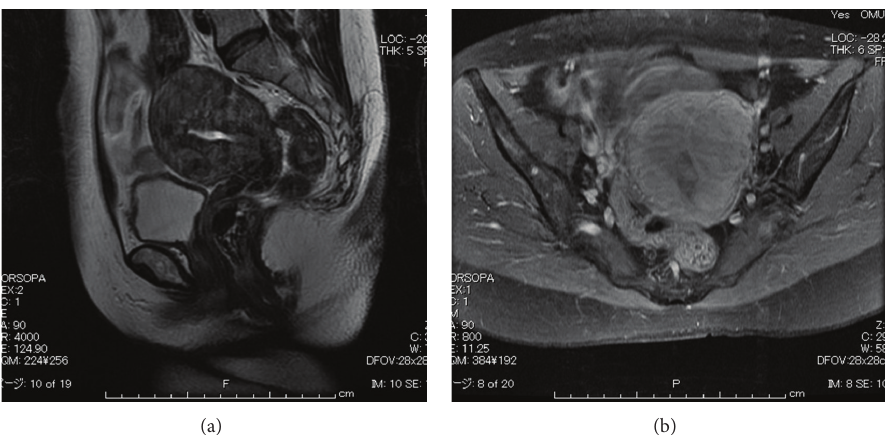
Figure 1:Magnetic resonance imaging revealed multiple myomas. Theendometrium was enhanced onT 1 -weighted imaging and endometrial cancer was suspected (b). Myometrial invasion was not evident.